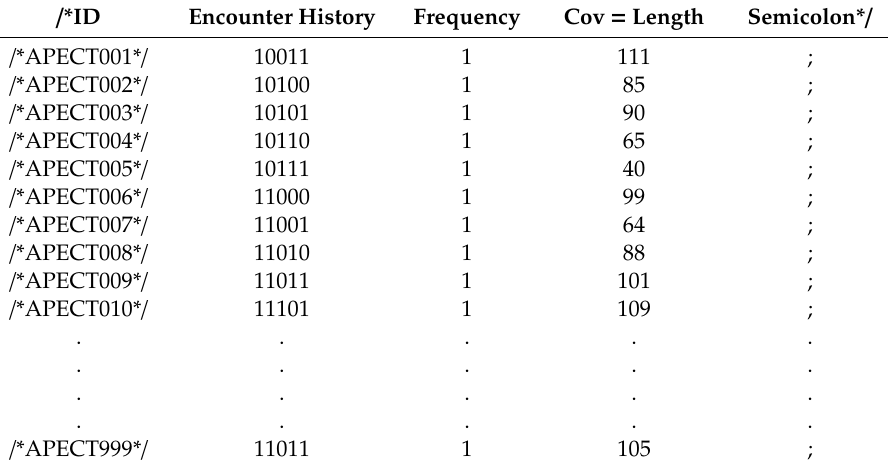
Table A2. An example of a Program MARK input file for Actinonaias pectorosa closed-population modeling. The first two columns represent the unique mark (tag identification) of an individual and its associated encounter history over five sampling occasions. The next column represents encounter history frequency (1s when modeling individual encounter histories), followed by a column for an individual covariate (mean shell length at capture within study period). The input files for Medionidus conradicus followed the same formatting, with the exception of the 2011 encounter histories that consisted of only four sampling occasions.